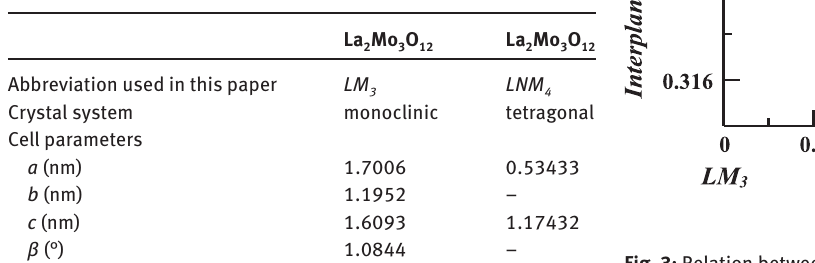
Table 2: Crystallographic data on La 2 Mo 3 O 12 and La 2 Mo 3 O 12 .